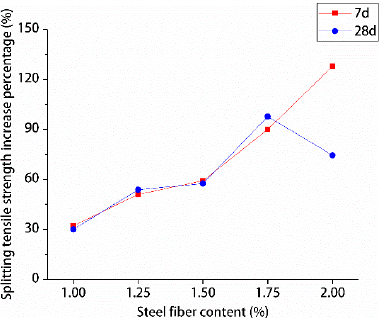
Figure 16. Increase percentage of splitting tensile strength.